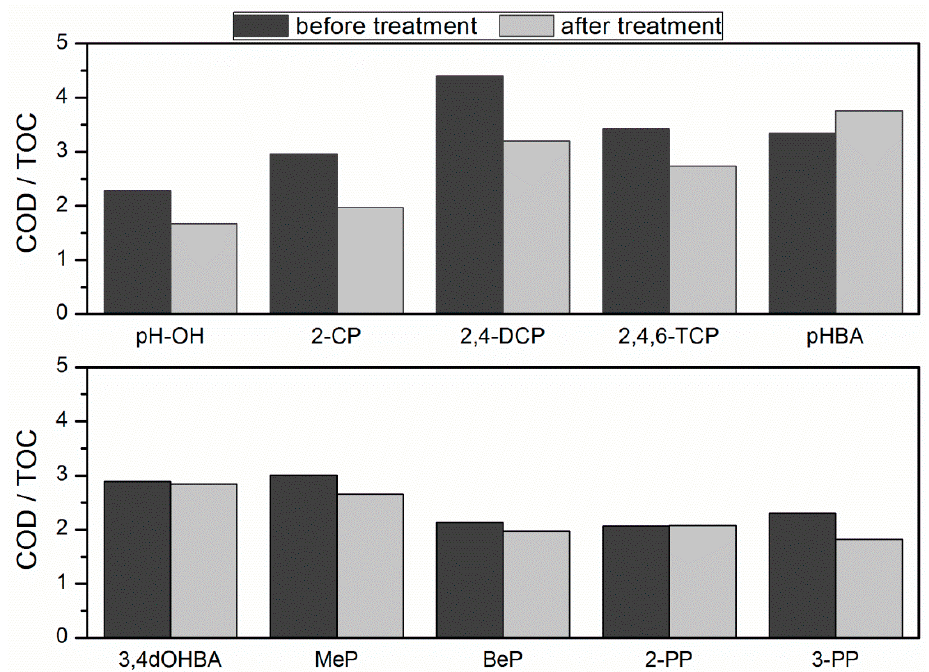
Figure 10. The COD/TOC ratio for samples before and after treatment. Figure 10. The COD / TOC ratio for samples before and after